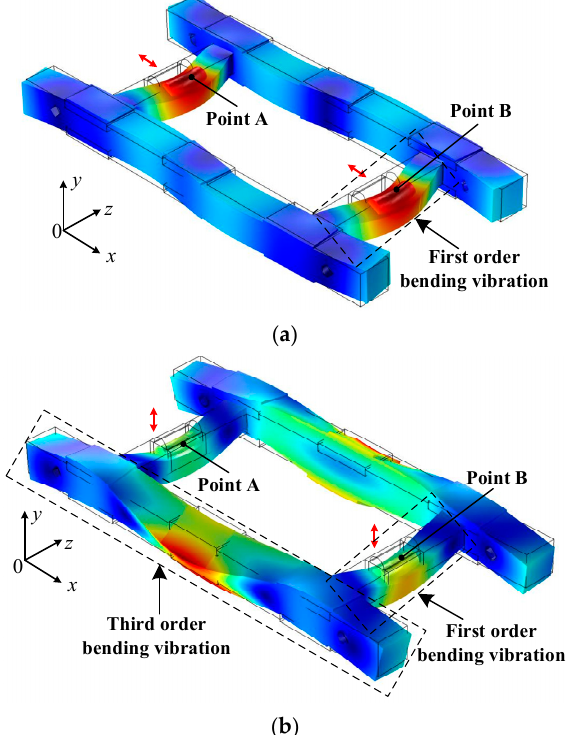
Figure 4. Simulation results of the proposed framed piezoelectric actuator. Vibration shapes when ( a ) the mode A and ( b ) the mode B are excited, respectively.